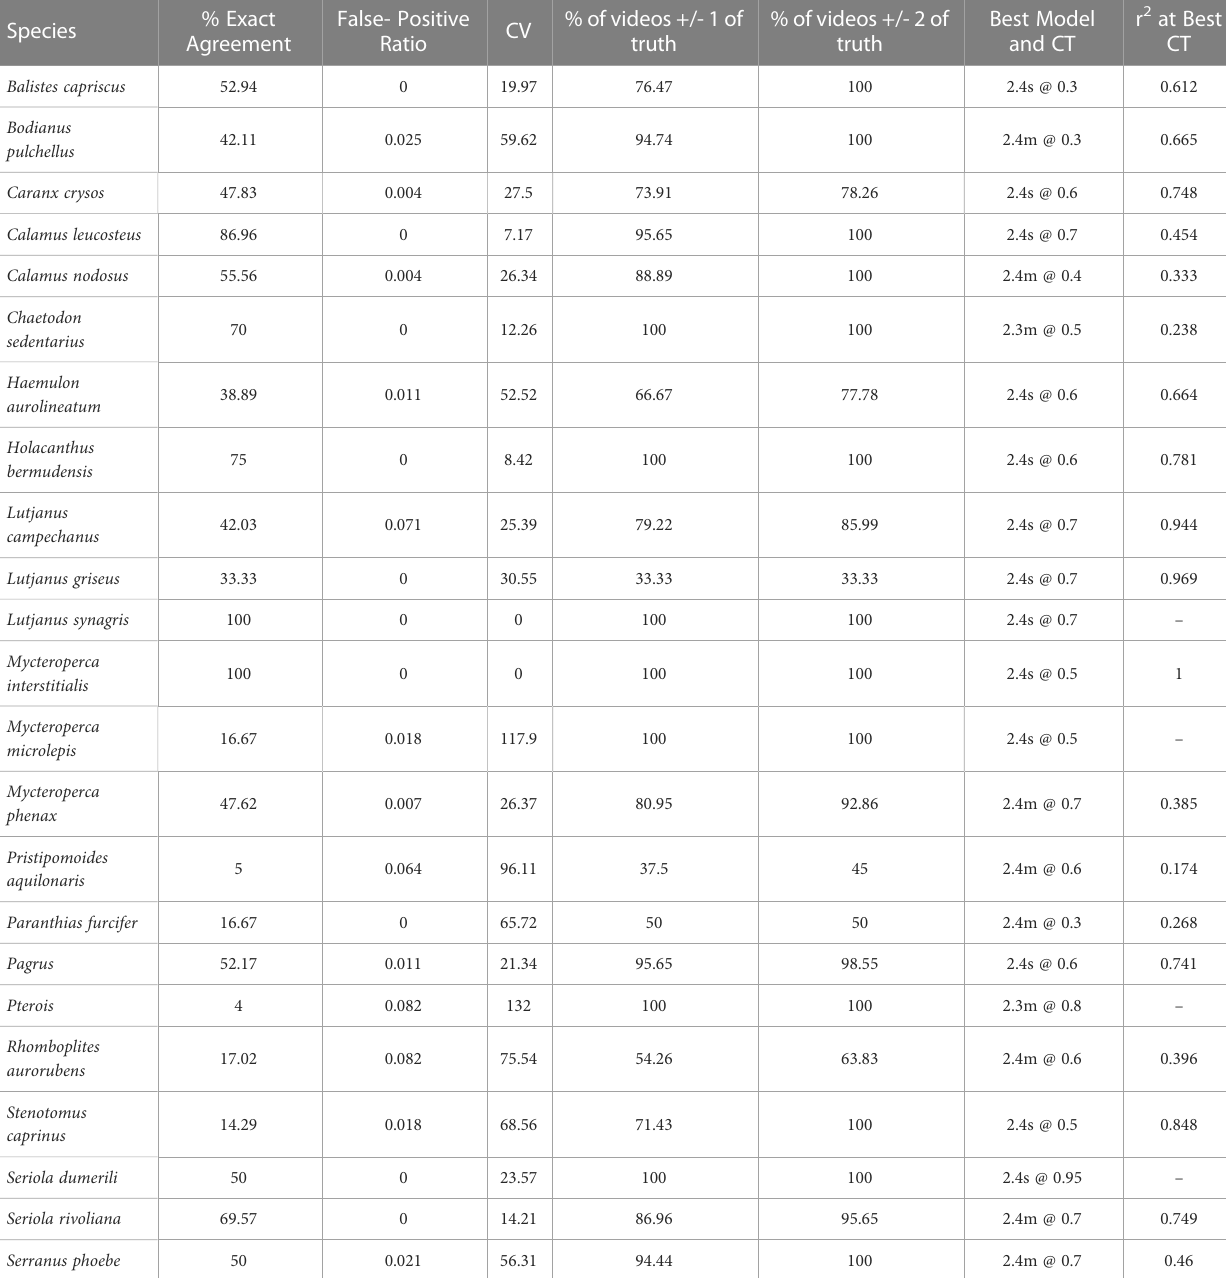
TABLE 1 Summary of model performance for 23 commercially and ecologically important species commonly observed in the 2021 SEAMAP Reef Fish Video Survey on reef structures along the shelf of the Gulf of Mexico West of the Mississippi River (< -89.5°